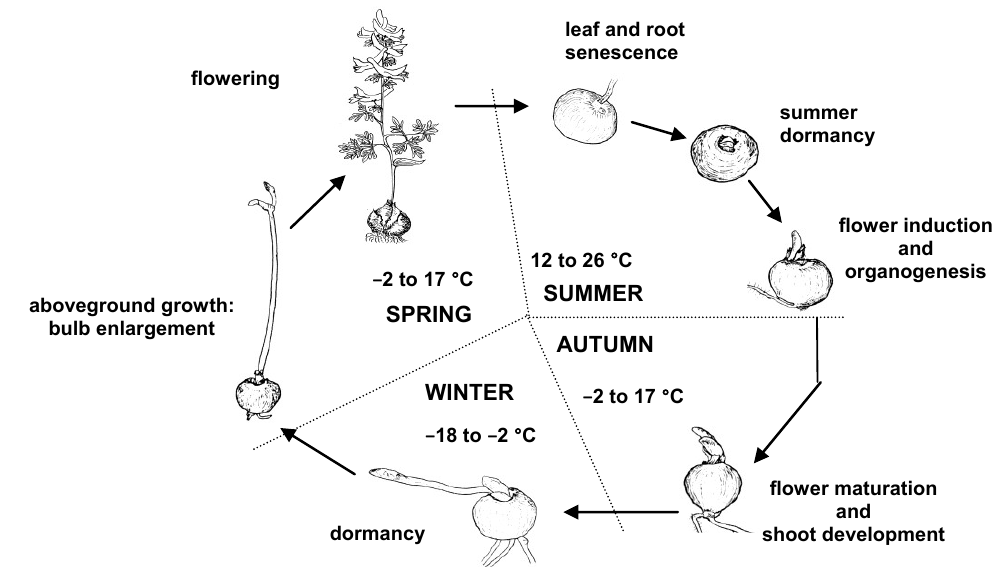
Figure 1. Schematic representation of the annual cycle of northern hemisphere geophytes using the example of Corydalis solida (adapted from [3]). The mean seasonal temperatures of a temperate continental climate are